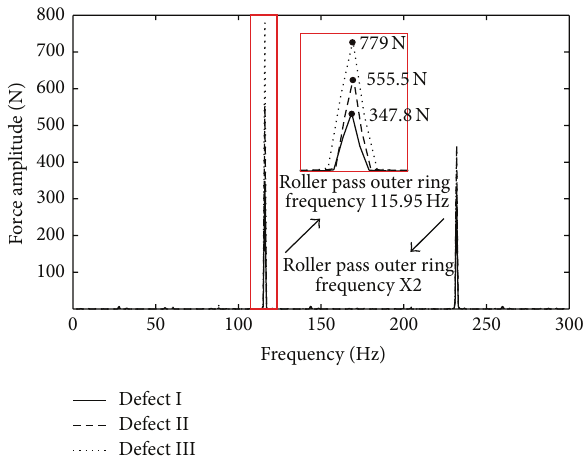
Figure 8: Defect size: force spectrum for defect on outer raceway in vertical direction.